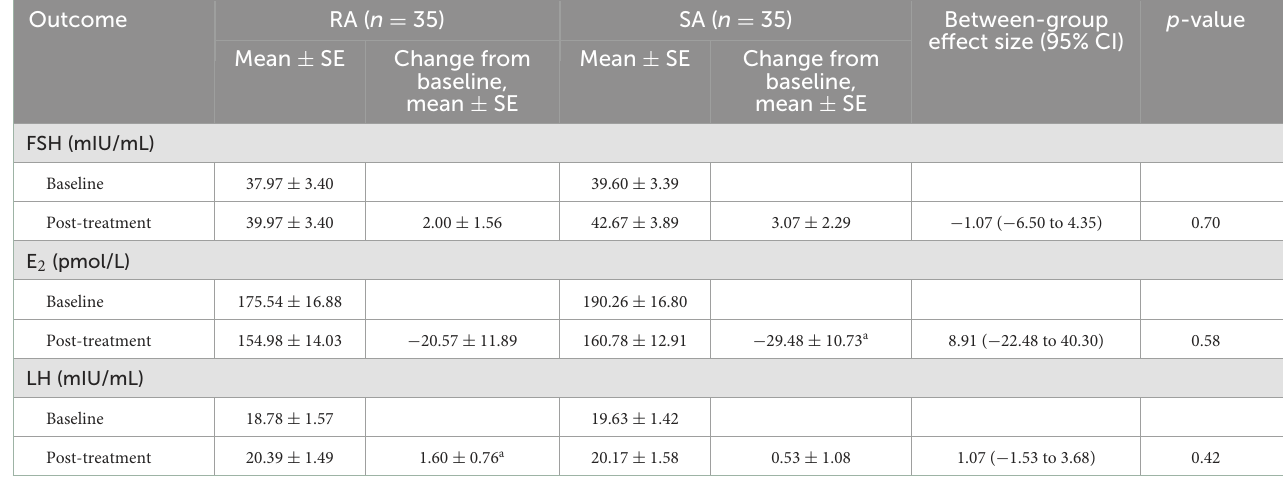
p -value effect size (95% CI)